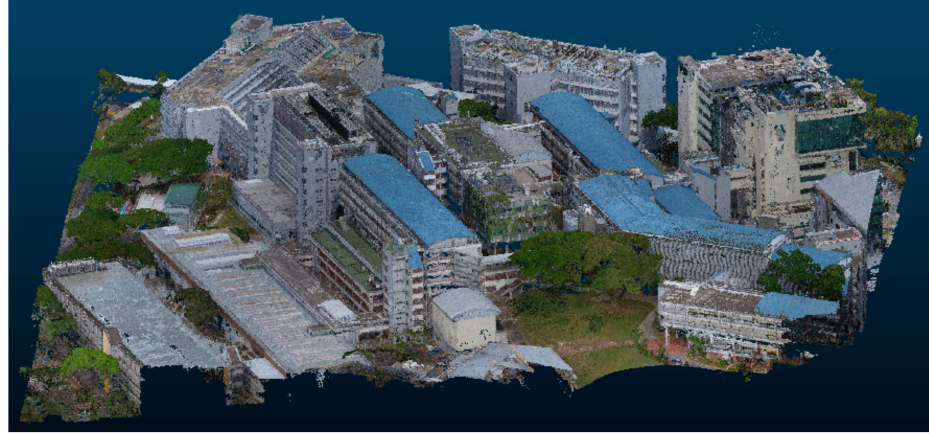
Figure 4. Dataset2, a larger area mainly consisting of the engineering faculty of